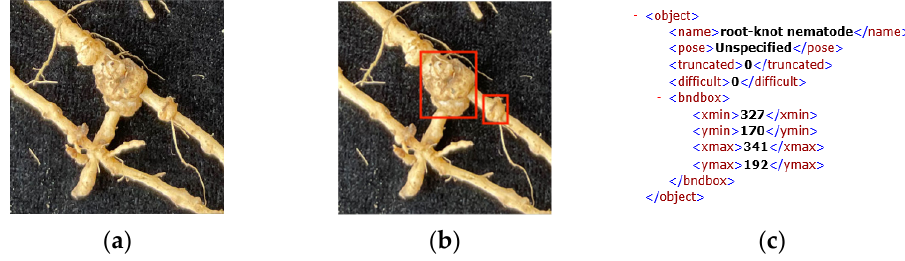
Figure 2. Image labeling process. ( a ) Original image, ( b ) Labeled image, ( c ) Label information.